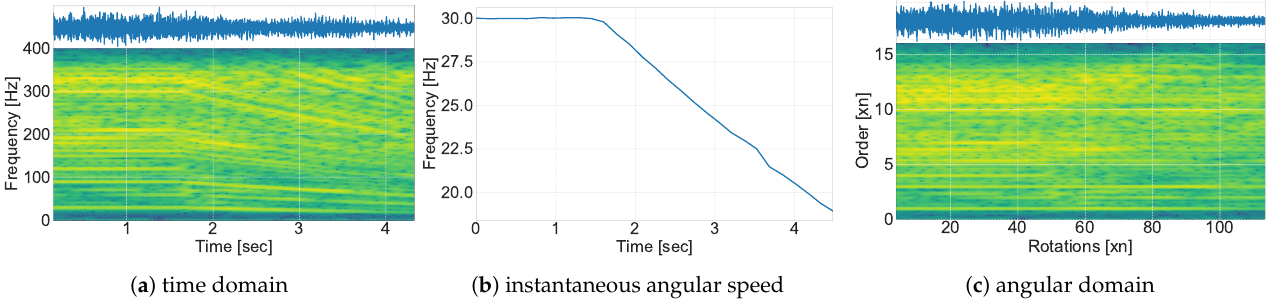
Figure 10. Examples of spectrograms estimated for a single IR fault